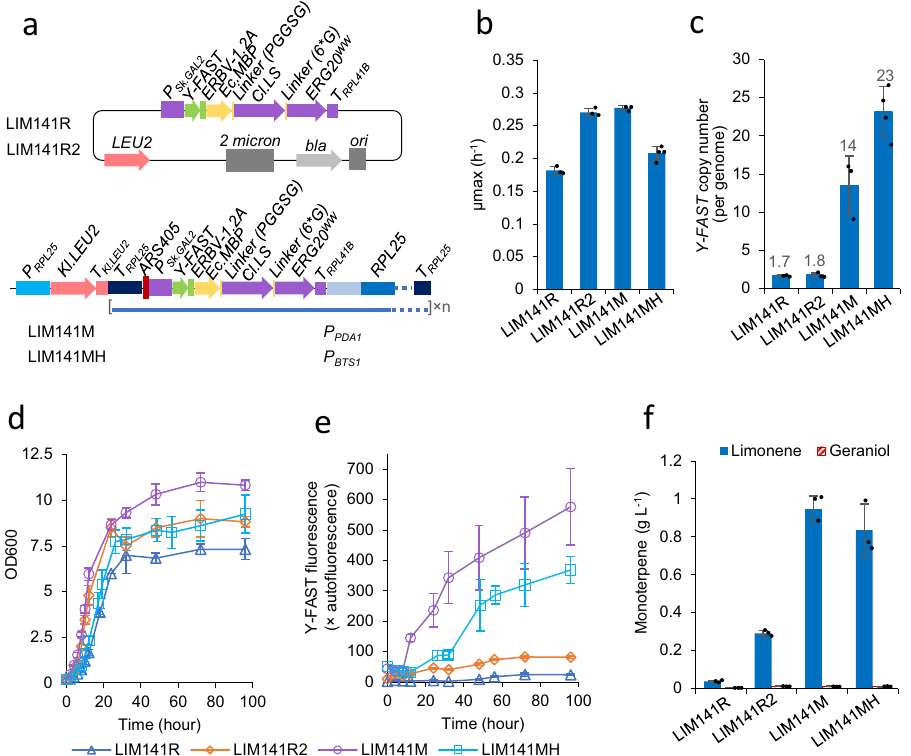
Fig. 4 Characterisation of limonene-producing strains with limonene synthetic genes on a 2 μ plasmid (LIM141R and LIM141R2) or integrated at ampli fi ed RPL25 locus (LIM141M and LIM141MH). LIM141R2 is one of LIM141R biological replicates. a Schematic map of genetic vectors used to introduce limonene synthetic genes into yeast. b – f Strain characterisation in two-phase fl ask cultivation with 20g l − 1 glucose and dodecane overlay. Synthetic auxin 1-Naphthaleneacetic acid (NAA) was added to 1mM at the late exponential growth phase (OD >4). Y-FAST fl uorescence was measured after 4-hydroxy-3- methylbenzylidene rhodanine (HMBR) with fi nal concentration 20 μ M was added to the yeast samples before fl ow cytometry assay and is expressed as fold- change of exponential-phase auto- fl uorescence of the reference strain GH4 30 . Limonene and geraniol production at 96 h was shown. Mean values±standard deviations are shown ( N = 3 independent biological replicates for LIM141R, LIM141M and three independent cultures for LIM141R2 in b – f . N = 4 independent biological replicates in b – e and three independent biological replicates in f for LIM141MH). Source data are provided as a Source Data fi le.